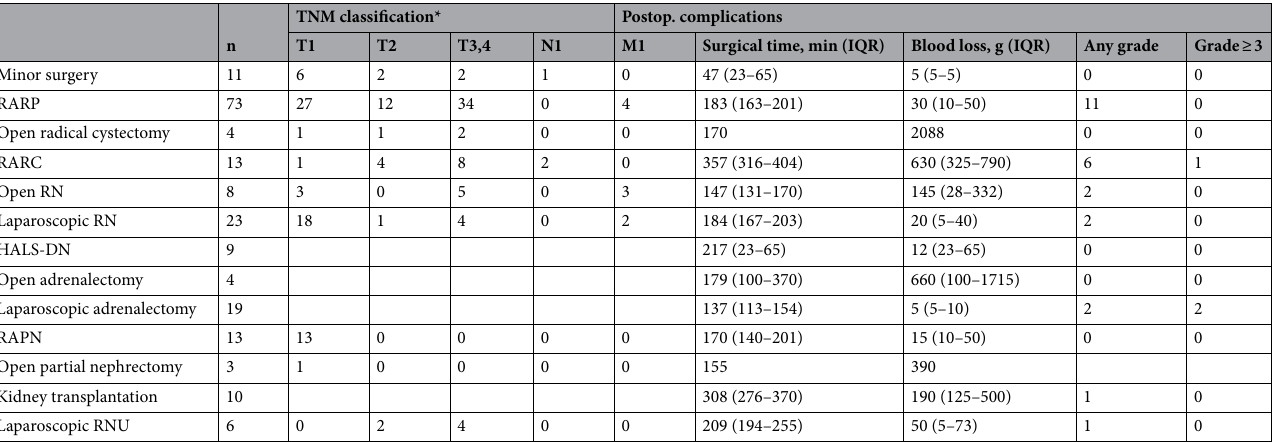
Table 2. Patient characteristics and surgical outcomes by type of surgeries. IQR interquartile range, RARP Robot-assisted radical prostatectomy, RARC Robot-assisted radical cystectomy, RN Radical